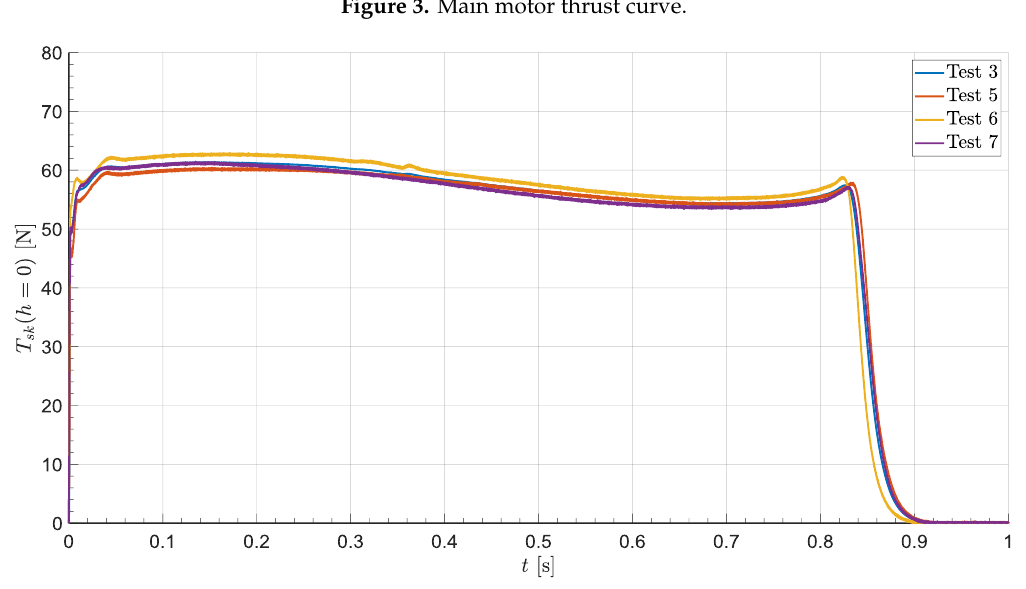
Figure 4. Lateral thruster thrust curves.